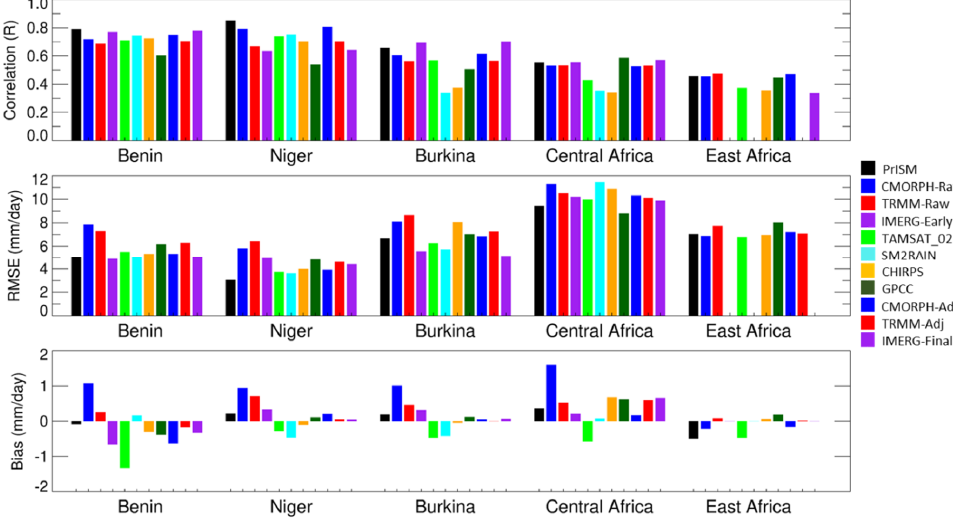
Figure 6. Statistical scores (R, root–mean–square error (RMSE) and bias) for the five regions (Benin, Niger, Burkina-Faso, Central Africa and East Africa) and for the 11 precipitation products. The temporal period depends on the satellite product and in situ